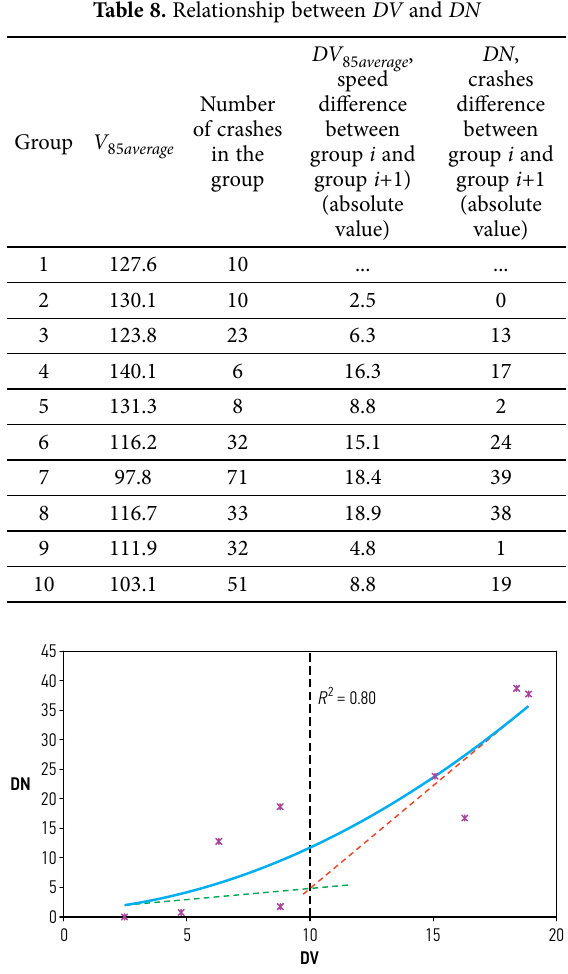
Fig. 5. Relationship between DV 85 average and DN